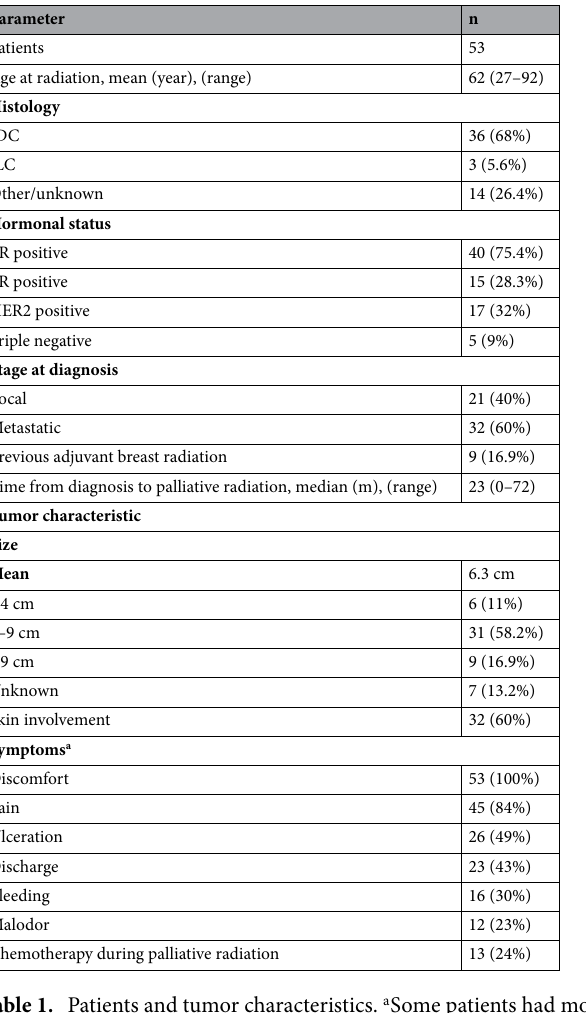
Table 1. Patients and tumor characteristics. a Some patients had more than one